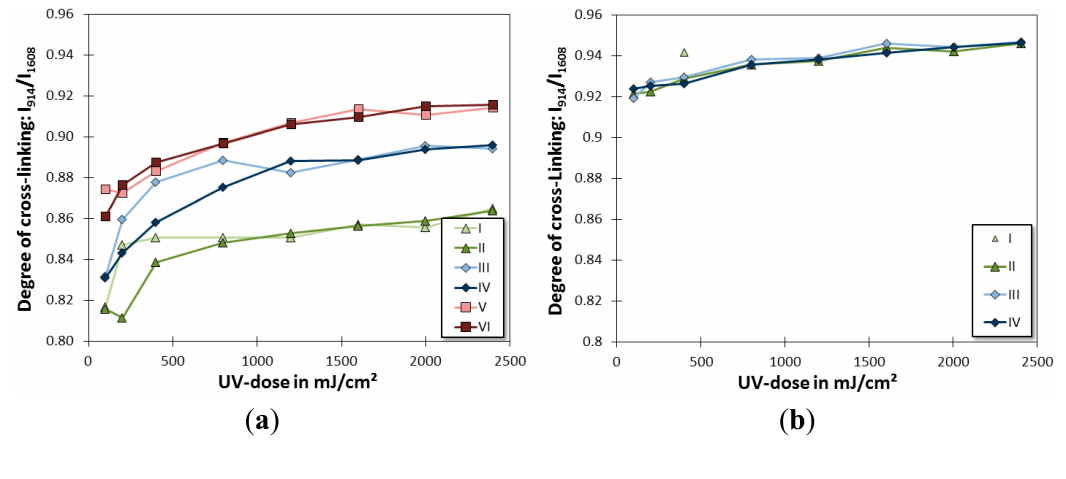
Figure 4. Relative degree of SU-8 cross-linking measured by FT-IR-spectroscopy: ( a ) After postbake and ( b ) after